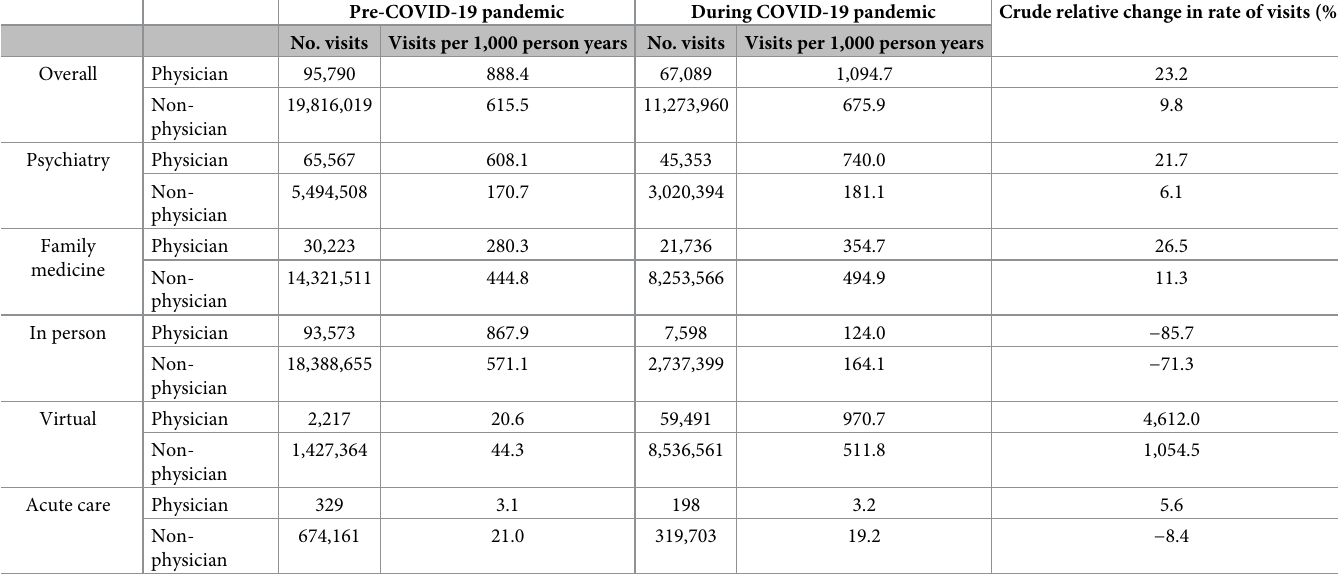
Table 2. Rates of MHA visits in physician and non–physicians in the 36 months pre–pandemic (March 11, 2017–March 10, 2020) and during the first 18 months of the pandemic (March 11, 2020–August 11, 2021).